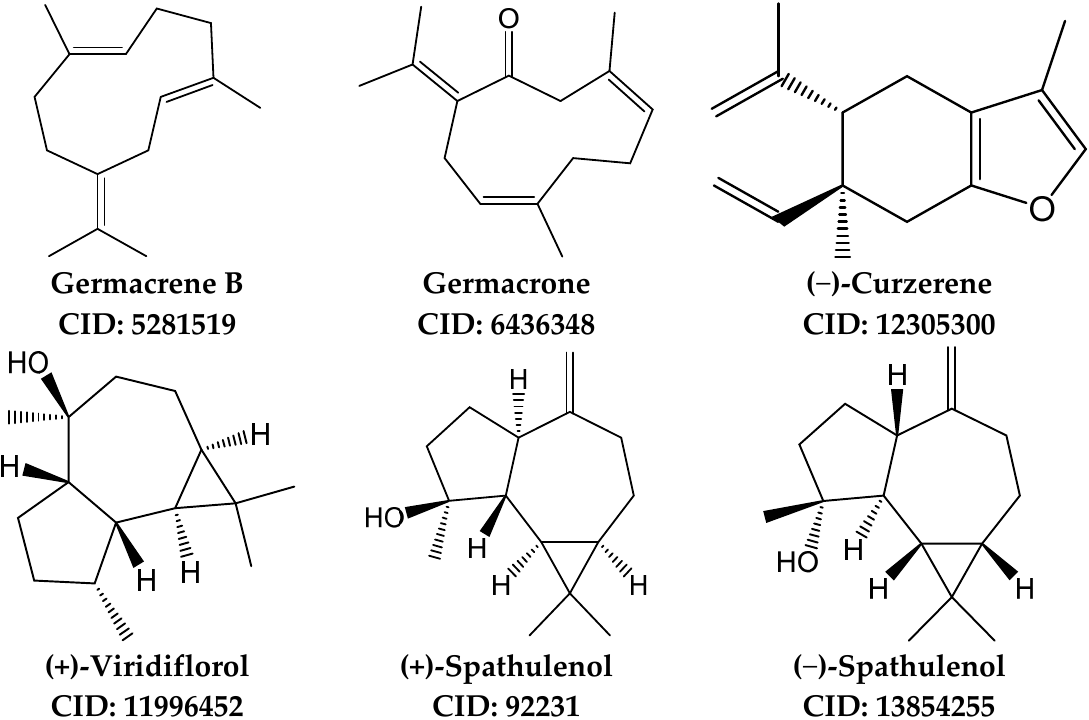
Figure 1. Chemical structures of major sesquiterpenes found in essential oils isolated from the leaves of R. albiflorum.